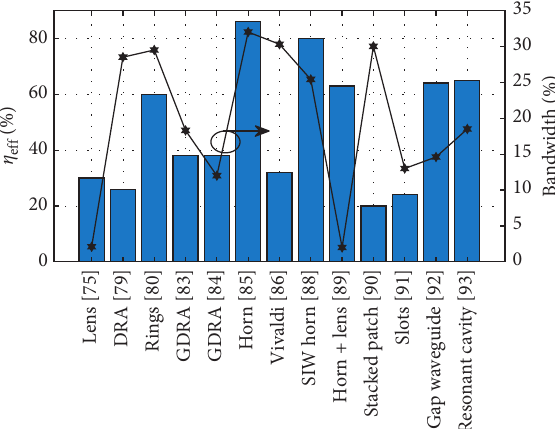
Figure 16: Aperture efficiency on the left axis and relative bandwidth on the right